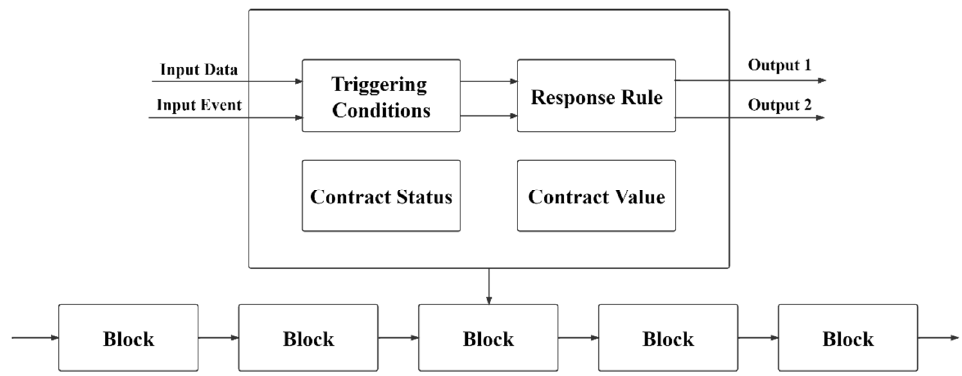
Figure 11. Schematic diagram of smart contract operation.